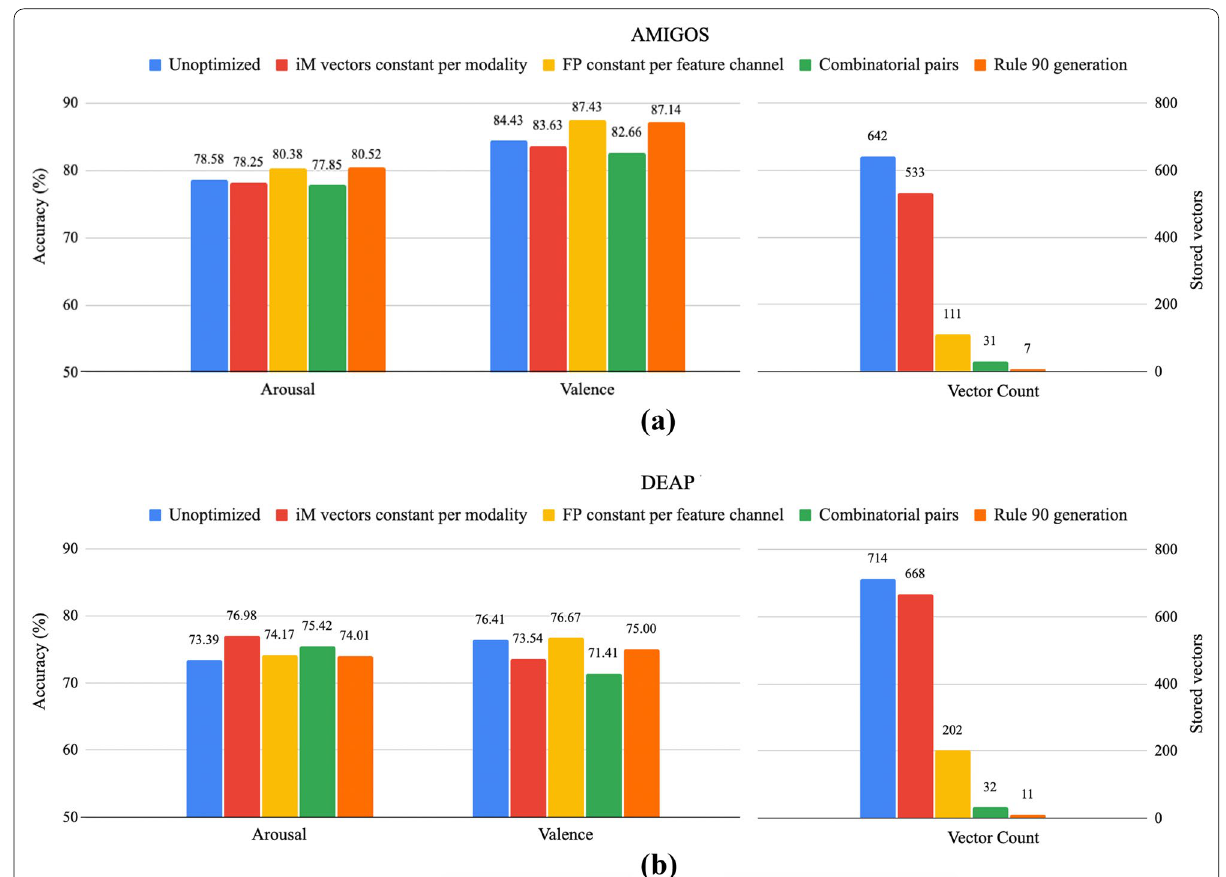
Fig. 6 Arousal and valence accuracies and required vector storage for the various memory optimization as compared to unoptimized for a AMIGOS and b DEAP data sets. Optimizations include ‘unoptimized’ with distinct iM and FP vectors for all channels, ‘iM vectors constant per modality’ with the same iM vectors between different modalities, ‘FP constant per feature channel’ with the same FP vectors between channels of the same modality, and ‘Rule 90 generation’ with generated FP and iM vectors on top of the previous optimizations